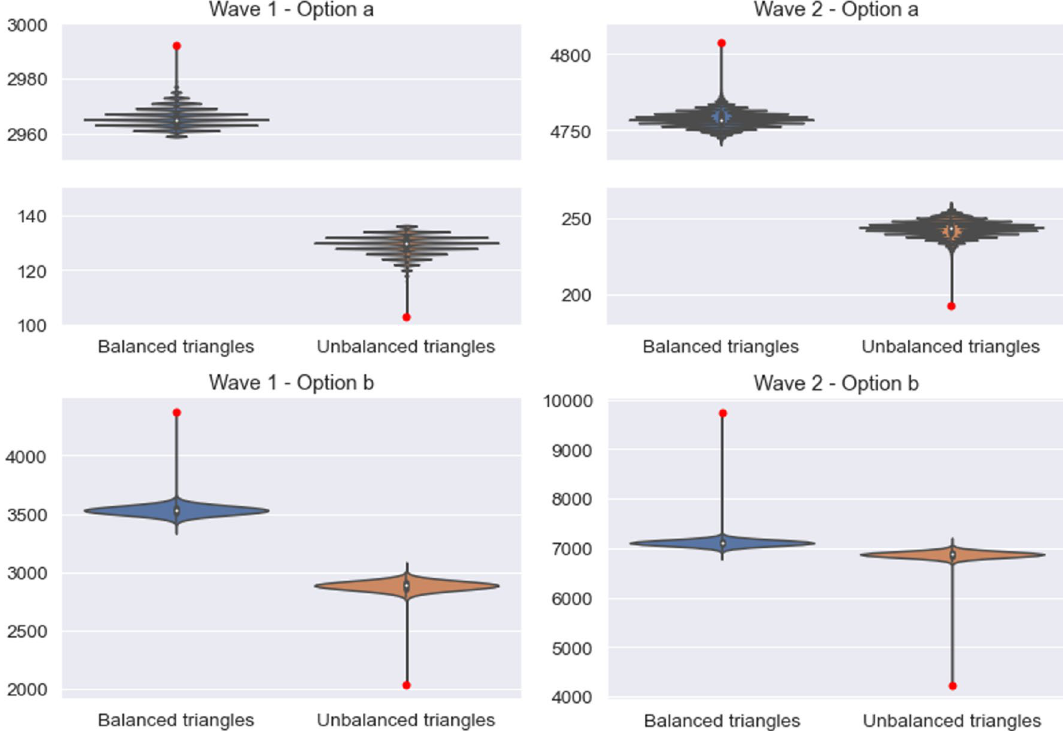
Figure 9. Comparison between the observed number of balanced and unbalanced triangles and the results obtained in the simulations. The red point represents the observed value and the violins correspond to the simulations. Left: Results obtained for the wave 1. Right: same for wave 2. Top: Option a: a link is considered negative only if the interaction between a pair of nodes is negative in both directions. Bottom: Option b: a link is considered negative as soon as there is a single negative interaction between a pair of